Question: Describe this figure in one sentence.
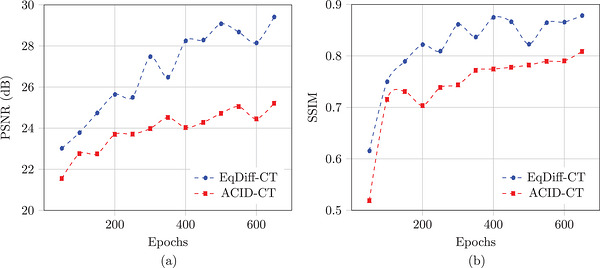
Answer: Ablation study for EqDiff‐CT and ACID‐CT (model without equivariance): (a) average PSNR (dB) over epochs and (b) average SSIM.